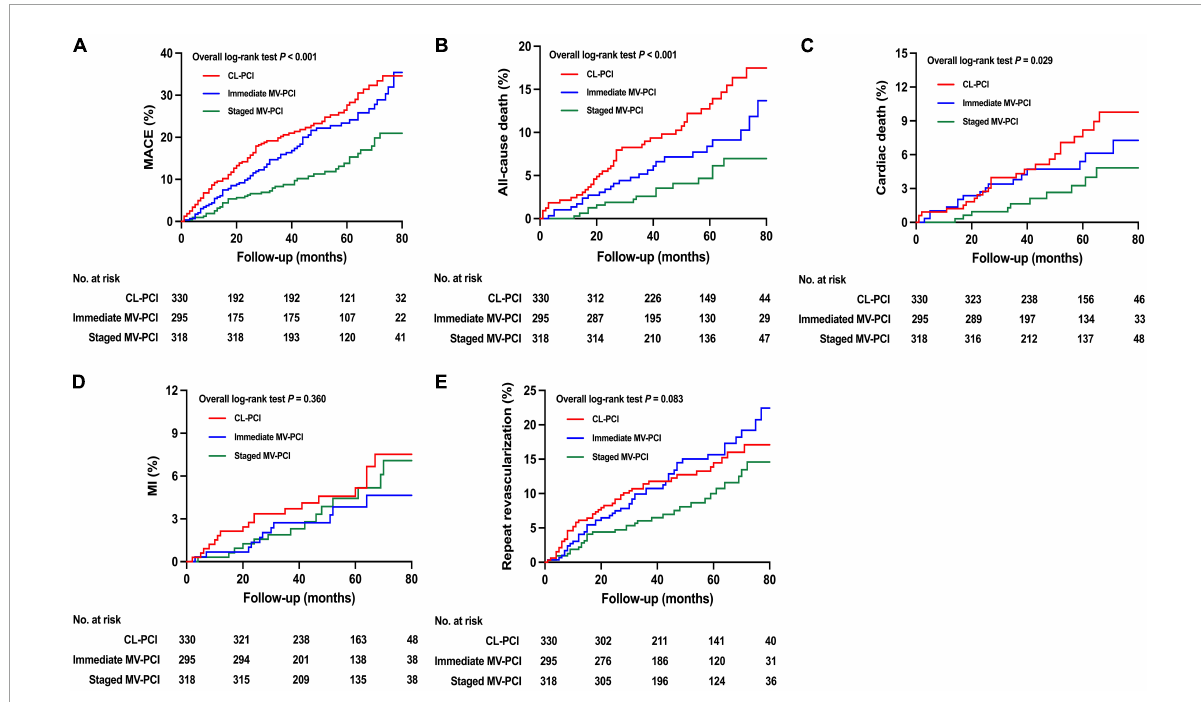
FIGURE2 Unadjusted clinical outcomes. Cumulative incidence of (A) MACE, (B) all-cause death, (C) cardiac death, (D) MI, and (E) repeat revascularization. MACE, major adverse cardiac events; MI, myocardial infarction; CL-PCI, culprit-only percutaneous coronary intervention; MV-PCI, multivessel percutaneous coronary